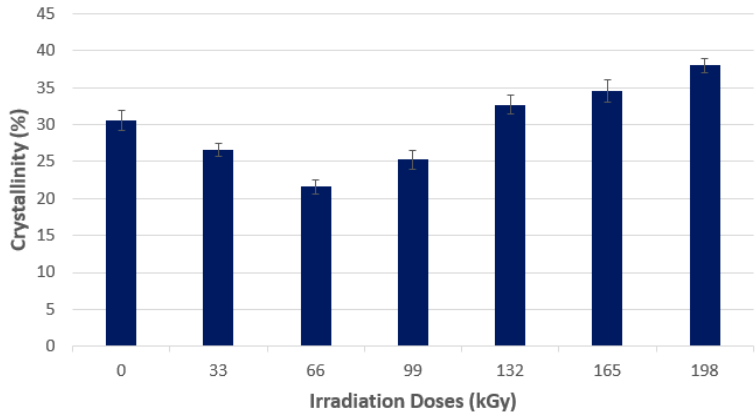
Figure 16. X-ray diffraction—Crystallinity—Technical polymers (PP 30% GF).